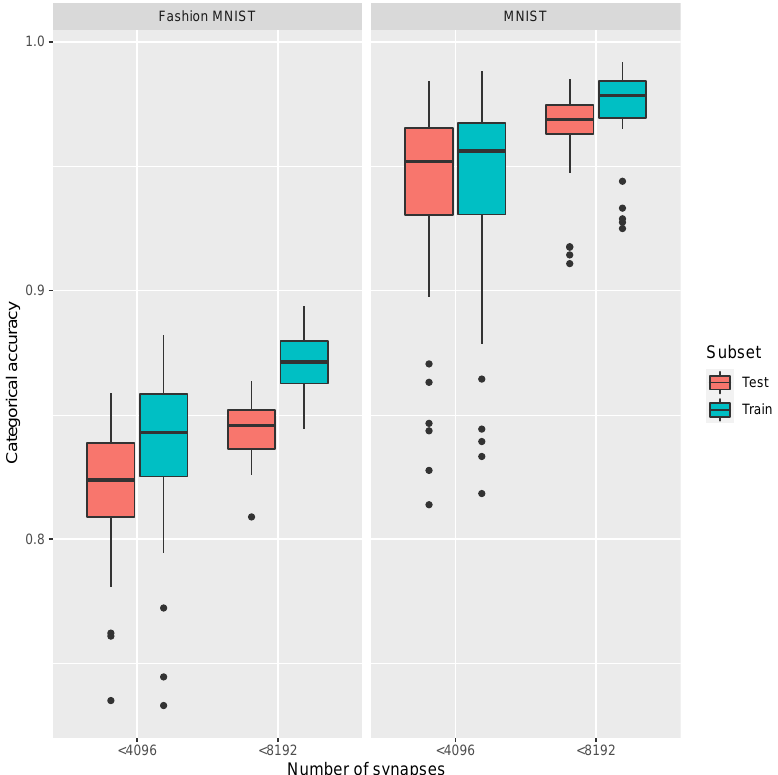
Figure 6. Boxplots for the categorical accuracy obtained for the MNIST and Fashion MNIST datasets in training and test for both FdNN and CNN with different number of synapses categorized in two groups: less than 4096 and between 4096 and 8192 synapses. For the sake of comparison, the results for both types of NNs are merged in just one box for each number of